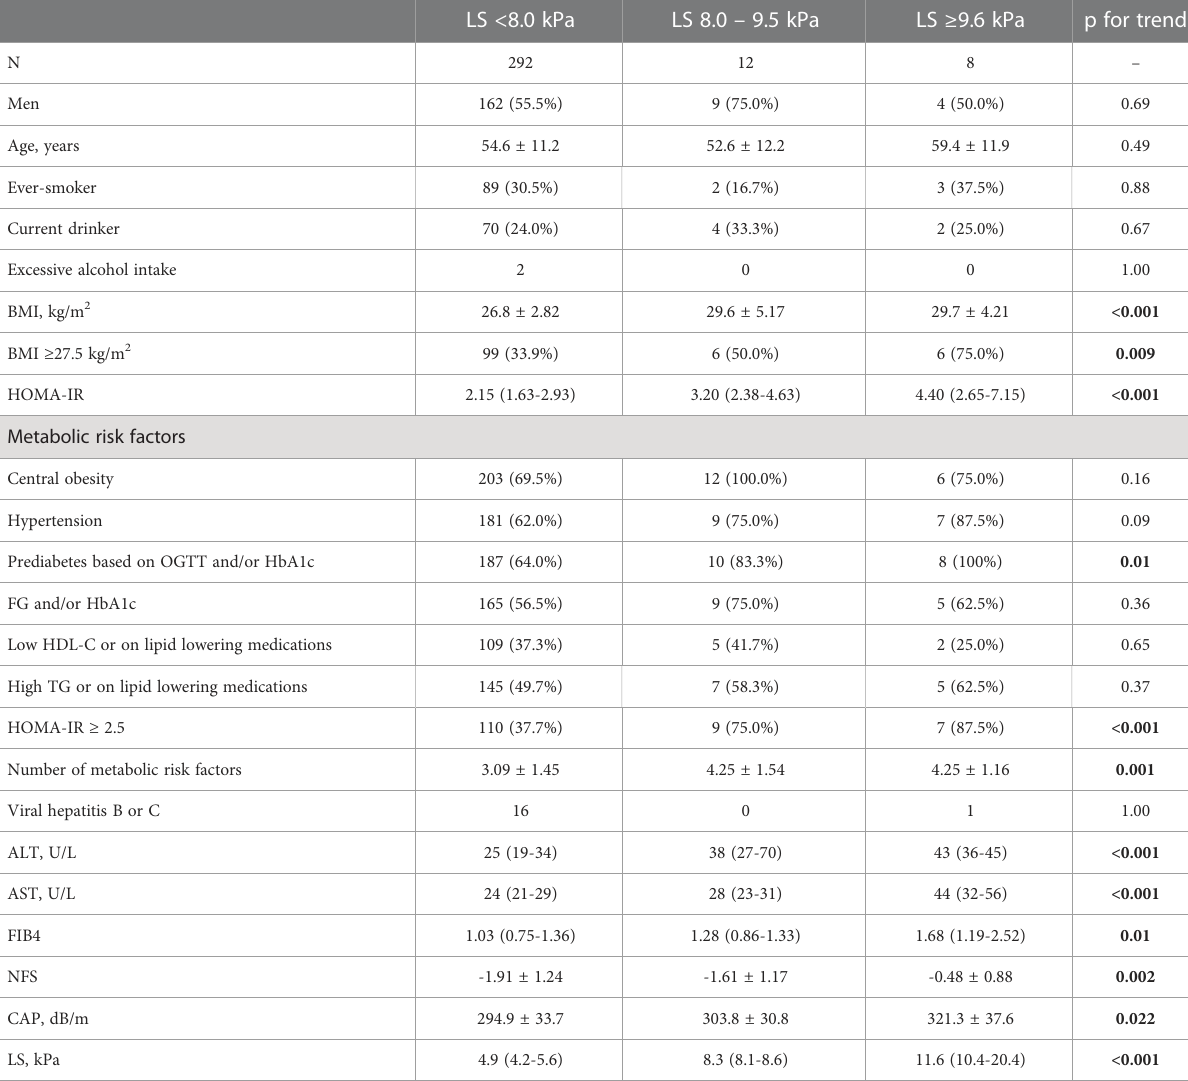
TABLE 2 Associations of clinical characteristics with the severity of liver fi brosis among participants with overweight/obese MAFLD